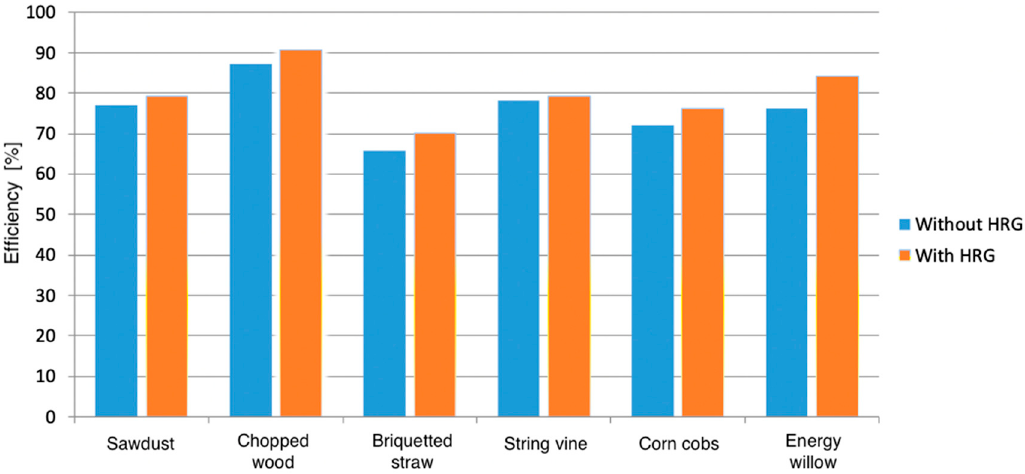
Figure 17. Combustion efficiency with/without HRG.